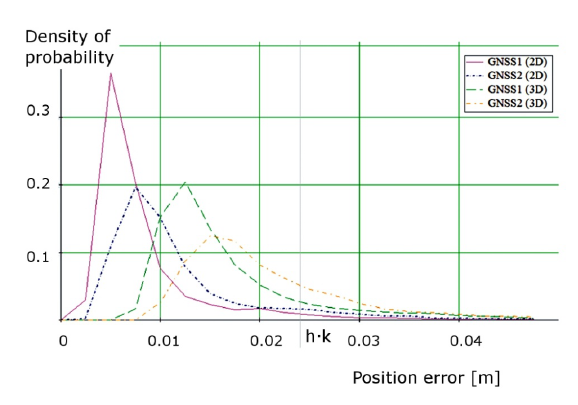
Figure 3: Probability density functions of GNSS position errors in 2D and 3D coordinate systems (measurements from